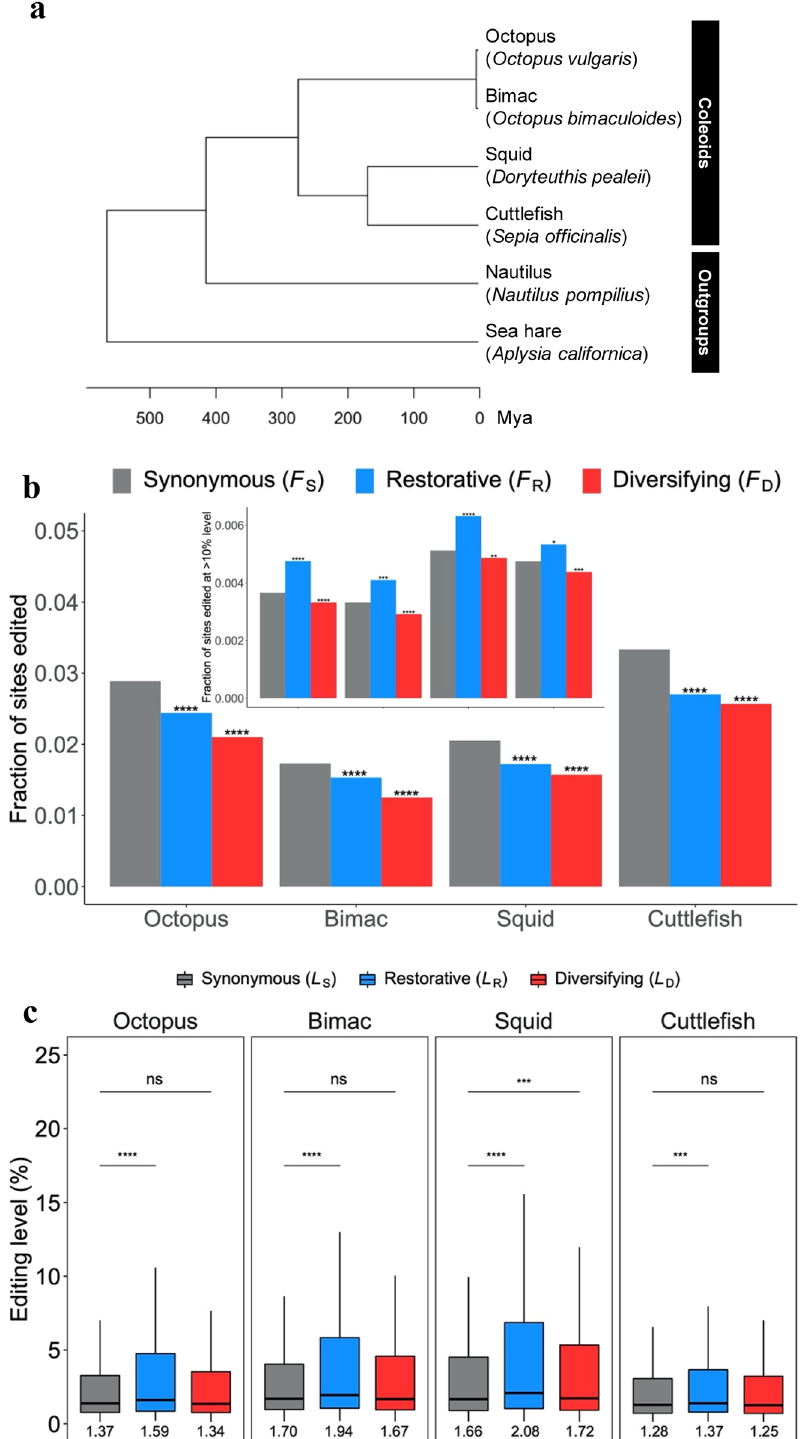
Fig. 2 Comparison of restorative and diversifying editing with synonymous editing in coleoids. a The phylogenetic relationship of the six mollusks studied here. Branch lengths represent divergence times based on the mid-points of the divergence time ranges in a previous study 27 . b Frequencies of sites with synonymous ( F S ), restorative ( F R ), and diversifying ( F D ) editing, respectively, in each of the four coleoids. A signi fi cant difference between F S and F R (or F D ) is indicated by stars above the bin of F R (or F D ) (* P < 0.05; ** P < 0.01; *** P < 0.001; **** P < 0.0001; ns, not signi fi cant; χ 2 -test). c Synonymous ( L S ), restorative ( L R ), and diversifying ( L D ) editing levels in each of the four coleoids. The lower and upper edges of a box represent the fi rst (qu 1 ) and third quartiles (qu 3 ), respectively, the horizontal line inside the box indicates the median (md), and the whiskers extend to the most extreme values inside inner fences, md± 1.5 (qu 3 − qu 1 ). The median editing levels are also given below the corresponding boxes. A signi fi cant difference between L S and L R (or L D ) is indicated by stars (* P < 0.05; ** P < 0.01; *** P < 0.001; **** P < 0.0001; ns, not signi fi cant; Mann – Whitney U -test). Source data are provided as a Source Data fi